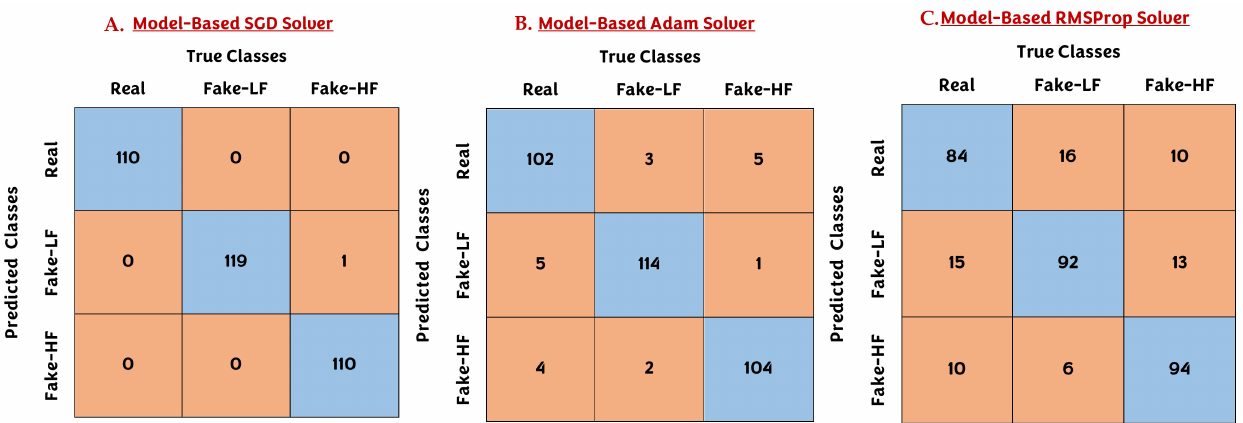
Figure 7. Confusion matrix analysis for the proposed transfer learning based ResNet50 model using three optimizers (solver) techniques: ( A ) using SGD solver, ( B ) using Adam solver, and ( C ) using RMSProp solver.